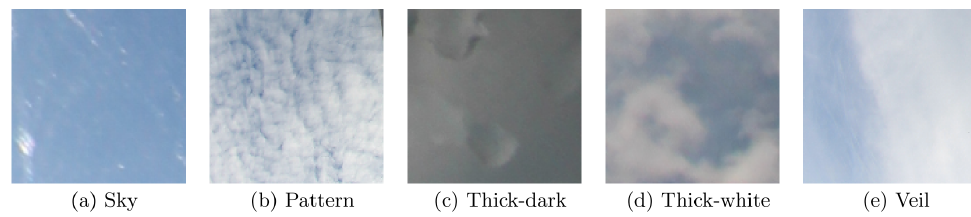
Figure 3. Selected images from five categories of the SWIMCAT dataset.